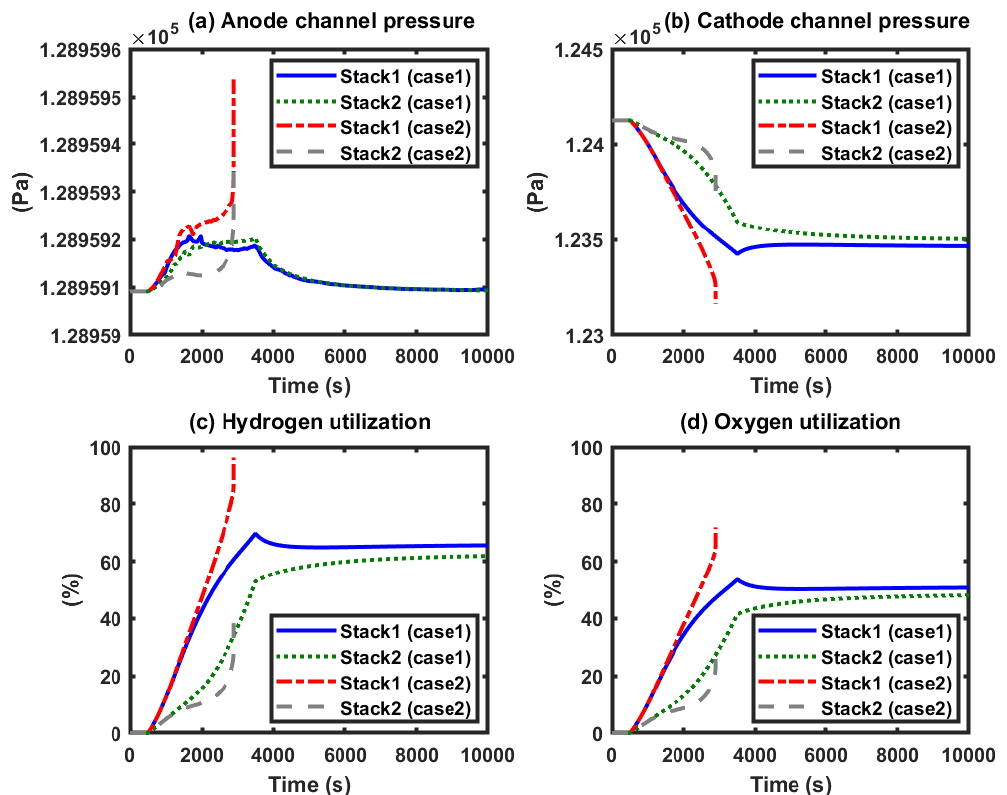
Figure 9. Transient response of the channel pressures and fuel utilizations when the two employed FC stacks have different ohmic properties. Case 1 includes the heat exchange between stacks, whereas case 2 excludes it. ( a ) Anode channel pressure, ( b ) cathode channel pressure, ( c ) hydrogen utilization, and ( d ) oxygen utilization. The channel pressures are almost the same, but the hydrogen utilization rate differs largely.